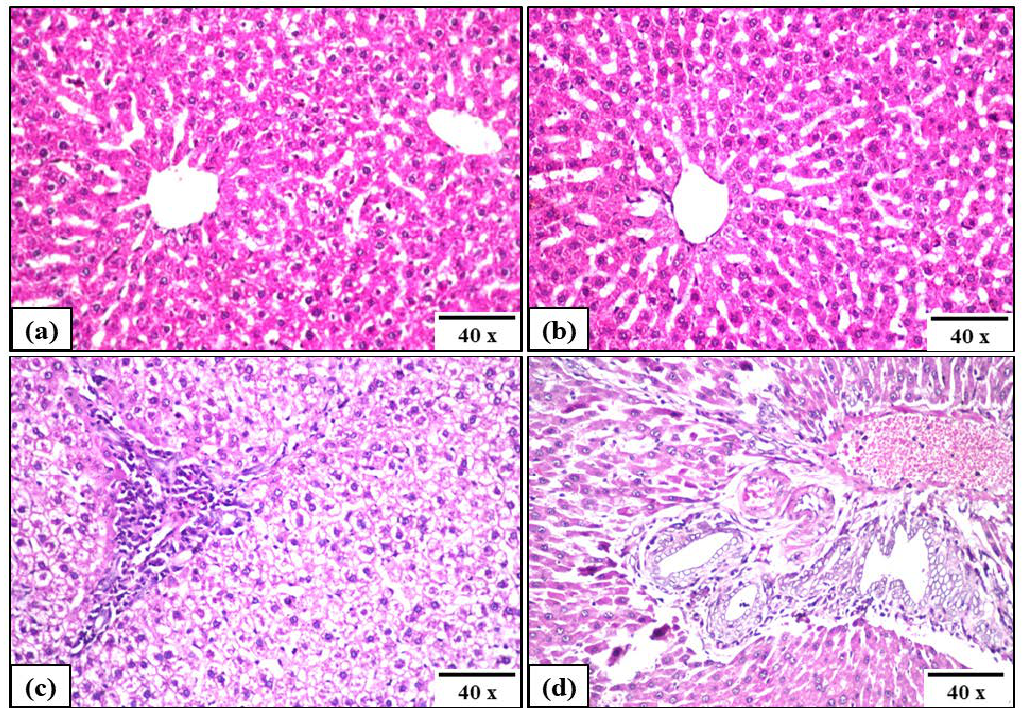
Figure 11. Effect of three MgS free from and doped with BaO on liver histopathology of tibia- fractured rats of different experimental groups: ( a ) sham control, ( b ) MgS,( c ) MgSdoped with 3% BaO (Ba3) and( d ) MgS doped with 5% BaO (Ba5).